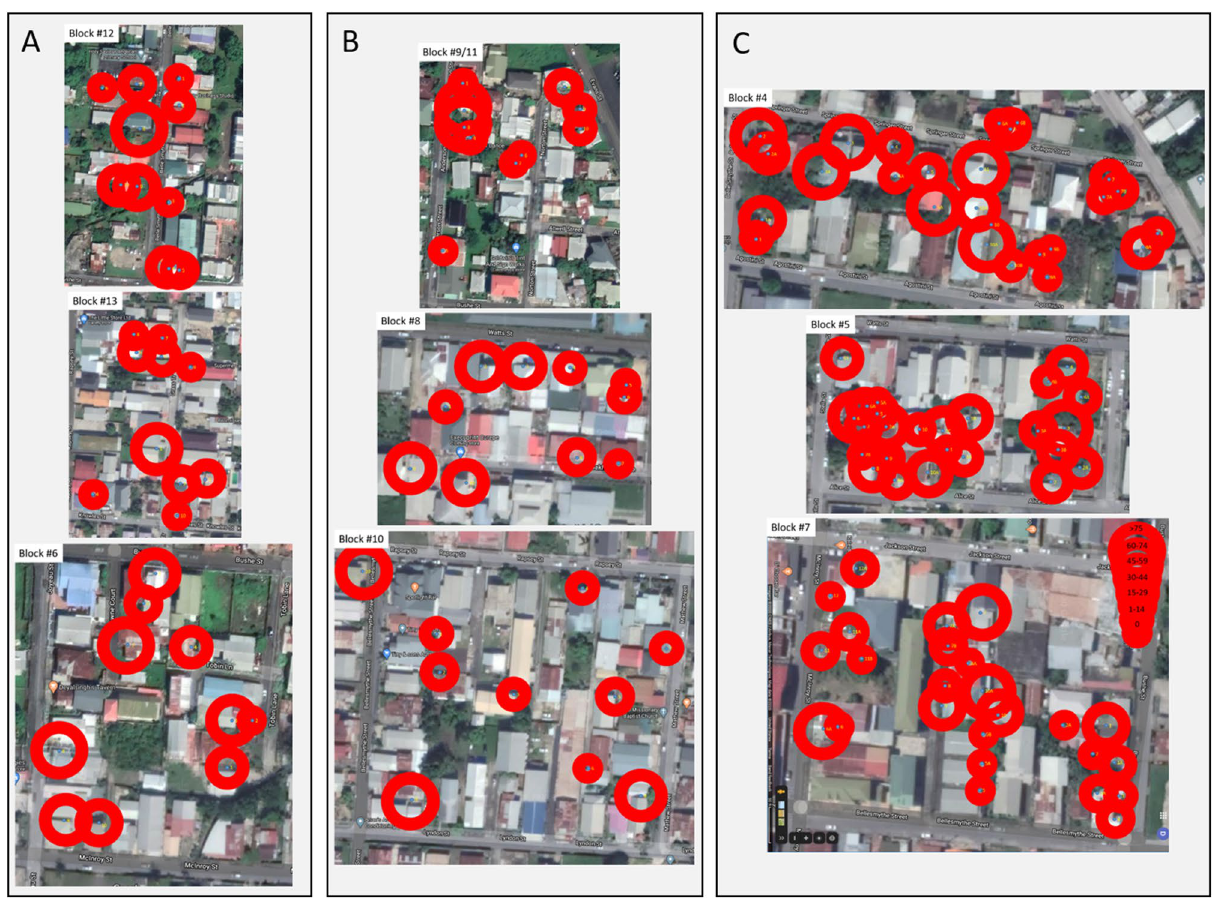
Figure 2. Individual yeast-baited 10 L ovitrap locations and median egg counts/trap from July to December 2019. ( A ) Control blocks; ( B ) Vector blocks; ( C ) Treatment